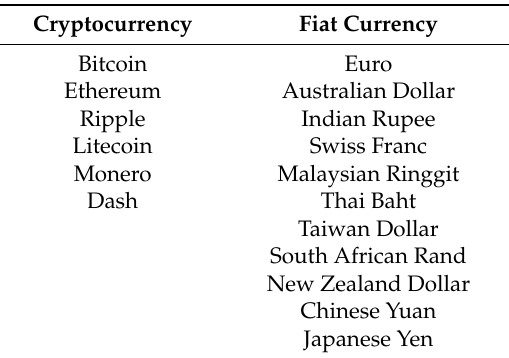
Table 1. Variables used in the